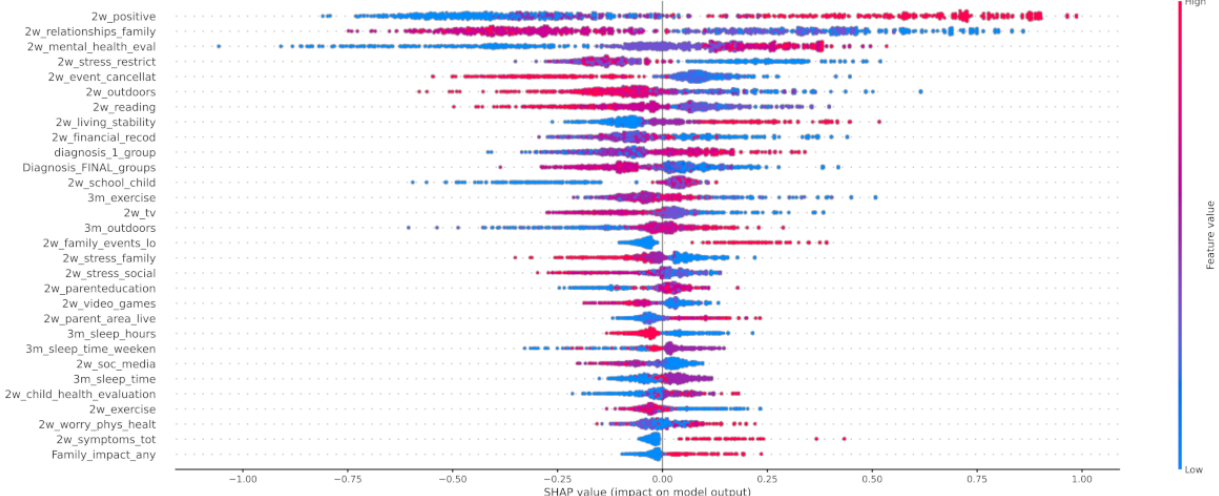
Figure 13. SHAP values of patients from class